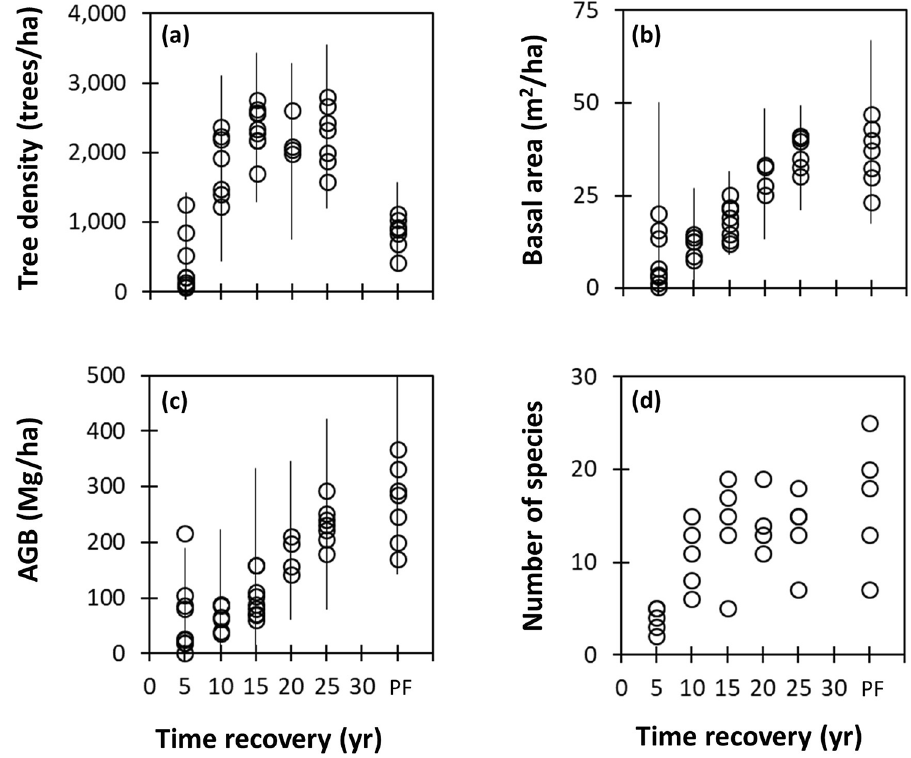
Figure 2. Forest structure recovery post-harvest, compared with intact protected mangrove forests, using measurement plots for ( a ) tree density, ( b ) basal area, ( c ) aboveground biomass (AGB), and ( d ) number of species. PF stands for Protected Forest, representing pristine mangrove conditions. Circles indicate mean value of forest structure from each plot, except for panel d which indicates total number of species. Error bars indicate standard deviation of overall